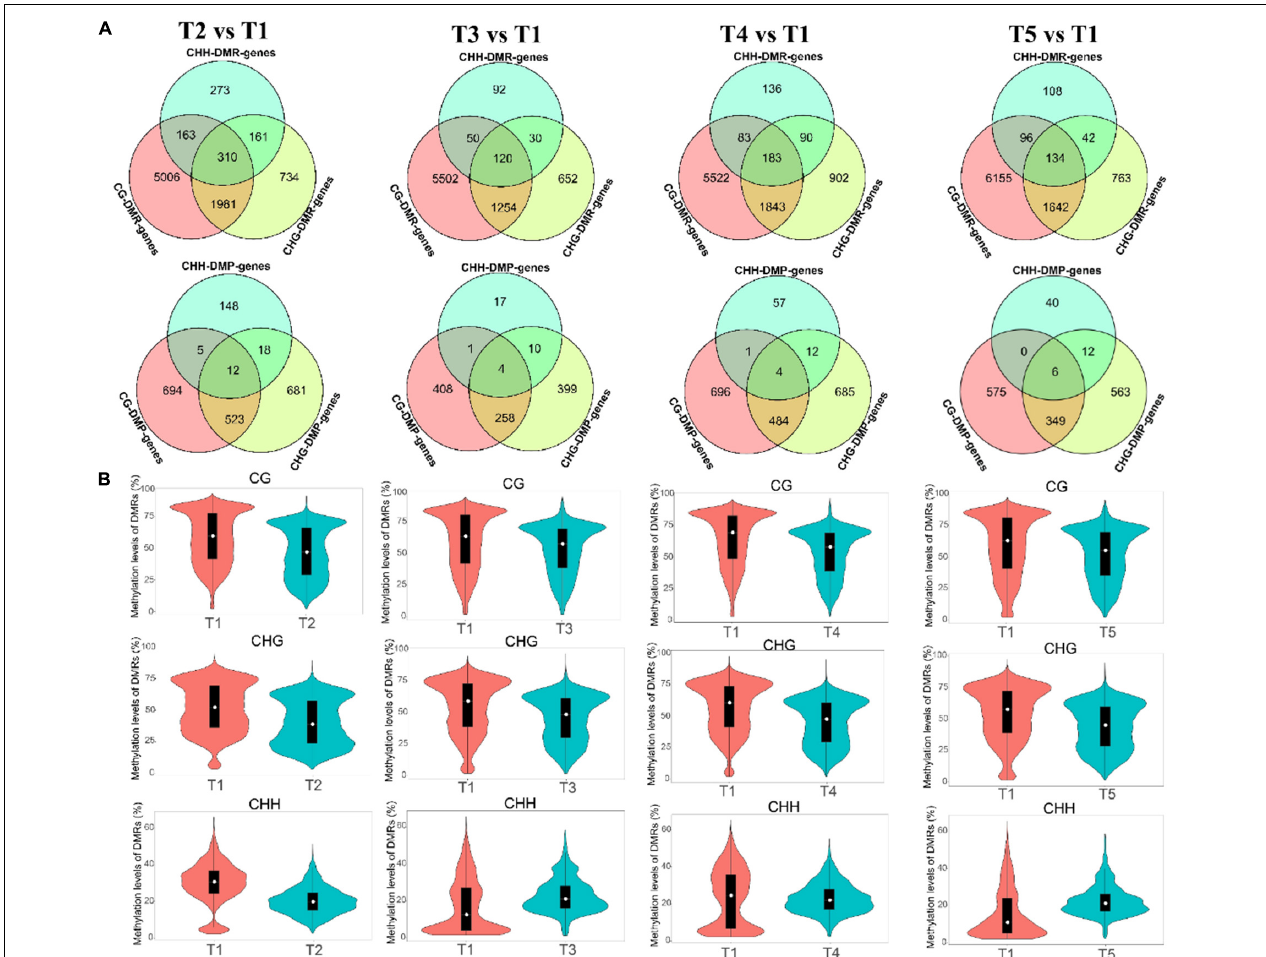
FIGURE 4 | Differentially methylated regions (DMRs) and DNA methylation levels at the T2 vs. T1, T3 vs. T1, T4 vs. T1, and T5 vs. T1 comparisons. (A) Venn analysis of genes with DMRs in the CG, CHG, and CHH contexts of gene-body regions (DMR genes) and promoter regions [differentially methylated promoter (DMP) genes] among the different comparisons. (B) DMR methylation levels in the CG, CHG, and CHH contexts of different comparisons.